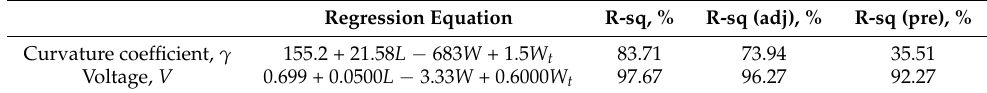
Table 13. Linear regression between control factors and response.